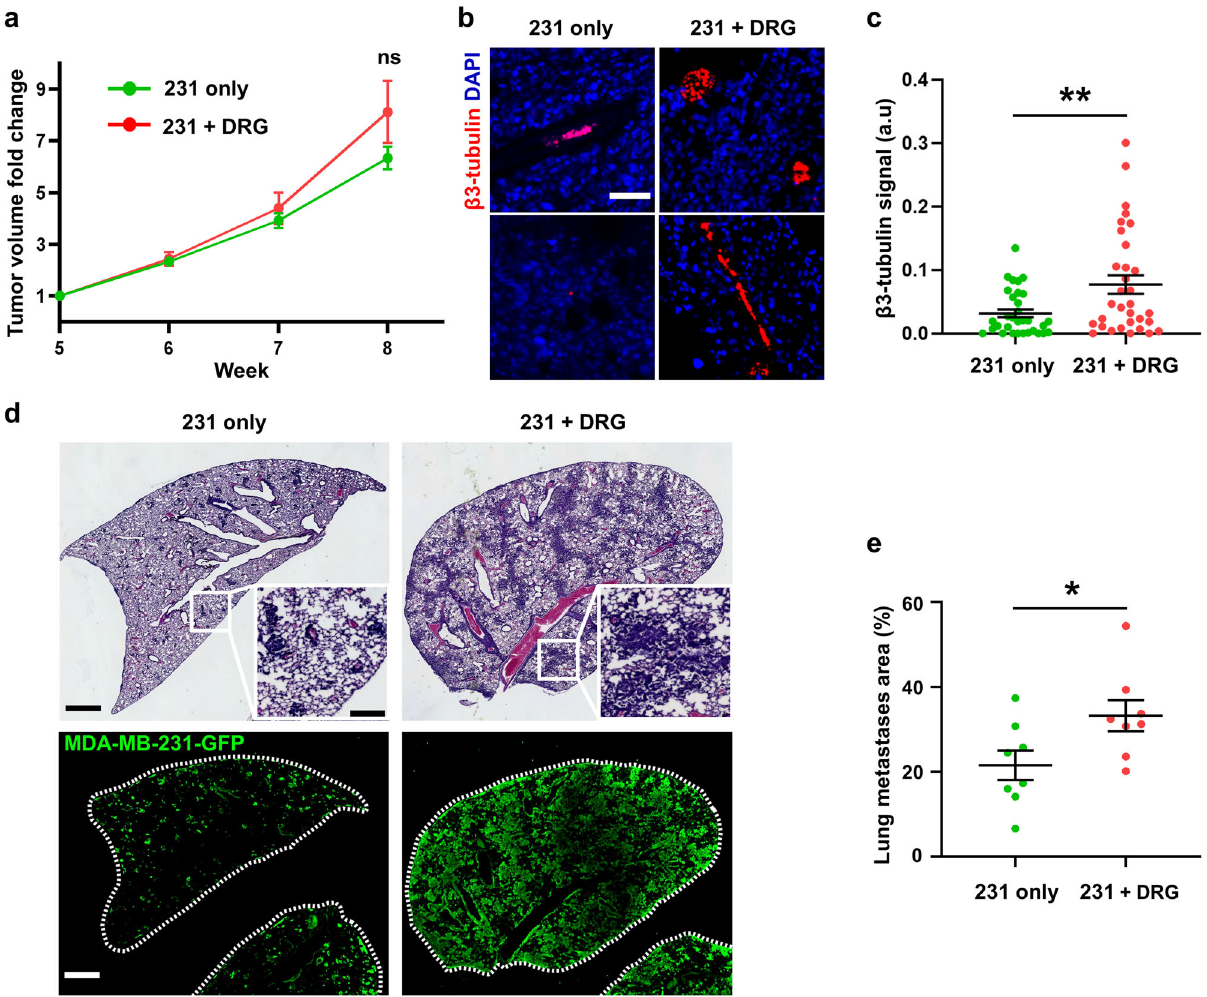
Fig. 2 DRG sensory neurons increased metastasis in vivo. a Tumor volume of mice injected with GFP tagged MDA-MB-231 cells alone or in combination with DRG sensory neurons measured over time, n = 8 for each group. b Representative images of immunostaining of mammary tumors for β 3-tubulin and nuclei with DAPI, scale bar denoting 50 μ m. c Quanti fi cation of β 3-tubulin signal intensity (a.u - arbitrary unit, n = 30 fi eld of views across 8 animals). d Upper: H&E staining of lung in injected mice, scale bar denoting 1000 μ m with insert showing higher magni fi cation view of individual metastases, scale bar denoting 200 μ m. Lower: immunostaining of lung metastasis in injected mice stained for anti-GFP antibody, scale bar denoting 1000 μ m. e Quanti fi cation of GFP + area in lung. Data show mean ± SEM. Signi fi cance was determined by unpaired student ’ s t test (* p = 0.038, ** p <